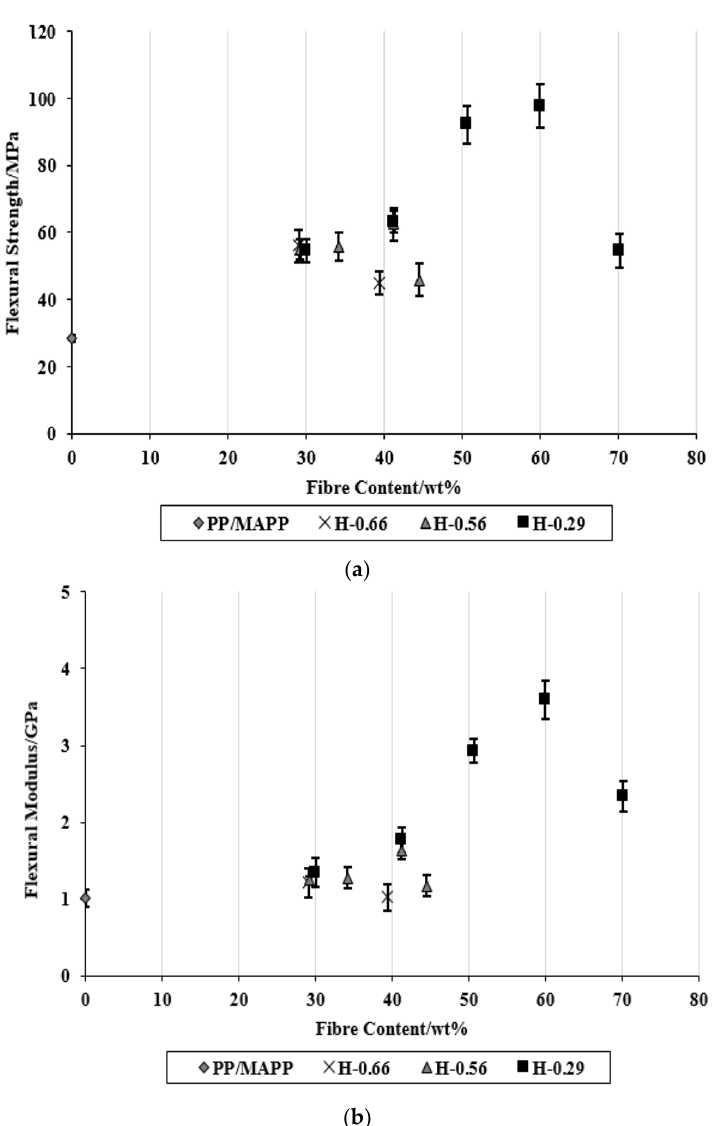
Figure 11. ( a ) Flexural strength and ( b ) flexural modulus of composites as a function of fibre